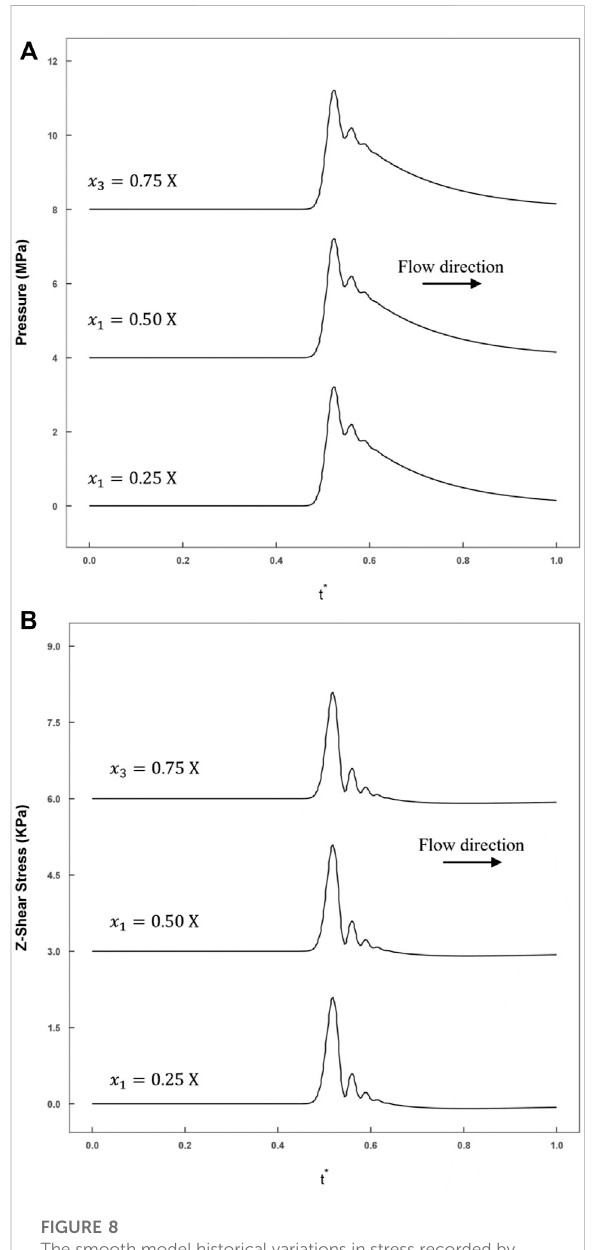
FIGURE 8 The smooth model historical variations in stress recorded by monitoring points calculated by FLUENT (blue line: rough model; red line: smooth model). (A) The axial shear stress recorded at three monitoring points ( x 1 (cid:2) 0 . 25 X , x 2 (cid:2) 0 . 5 X , x 3 (cid:2) 0 . 75 X ) attheline z (cid:2) 0 . 5 L ; (B)